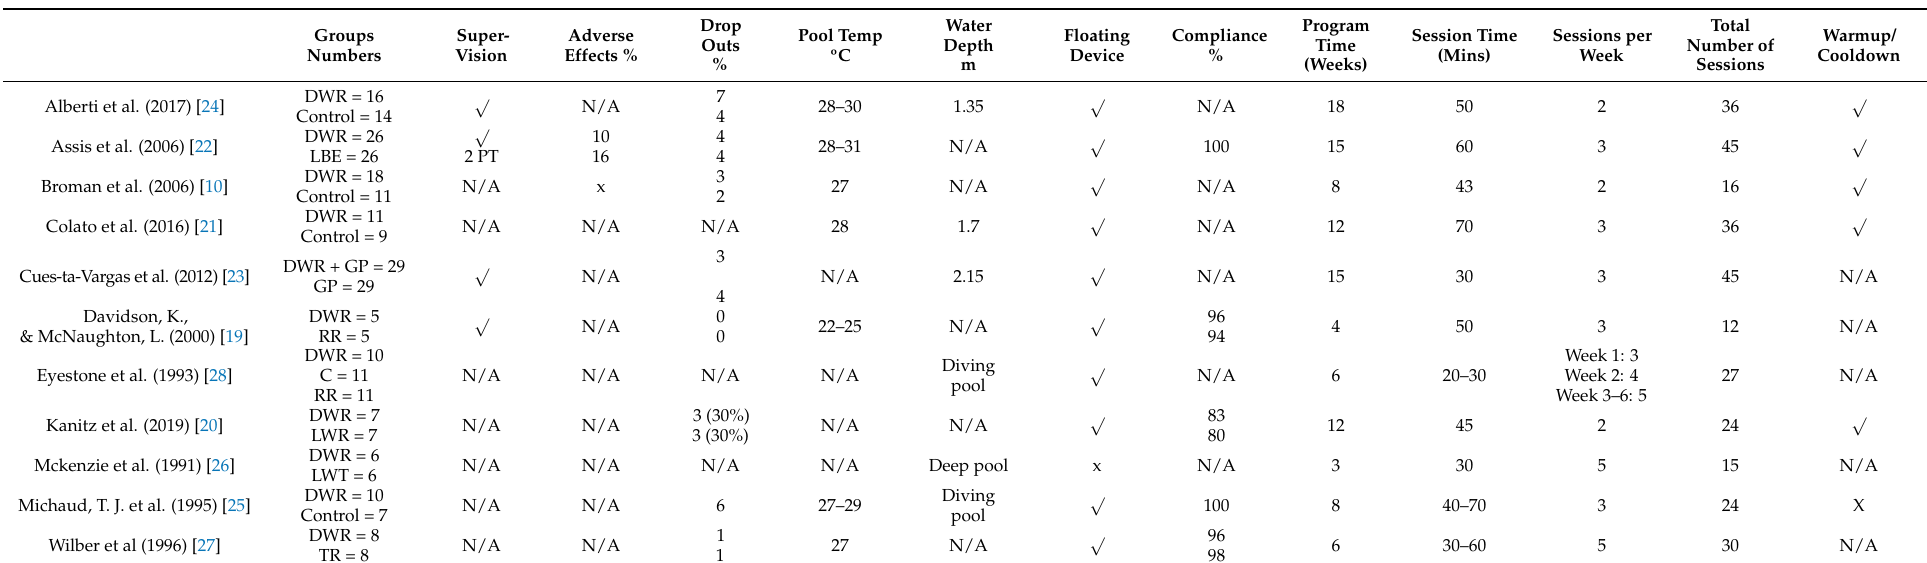
Table 3. Intervention design of included